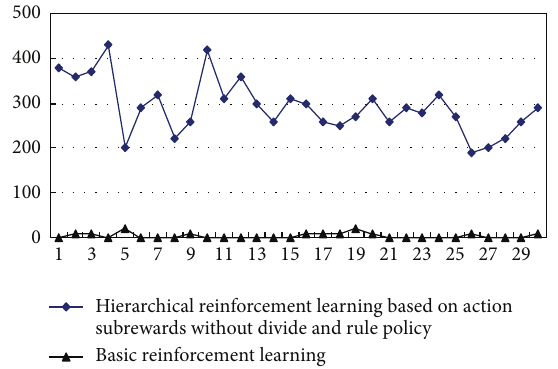
Figure 2: The performance comparison between hierarchical rein- forcement learning based on action subrewards without divide and rule policy and basic reinforcement learning. Figure 3: The performance comparison between divide and rule policy and nondivide and rule